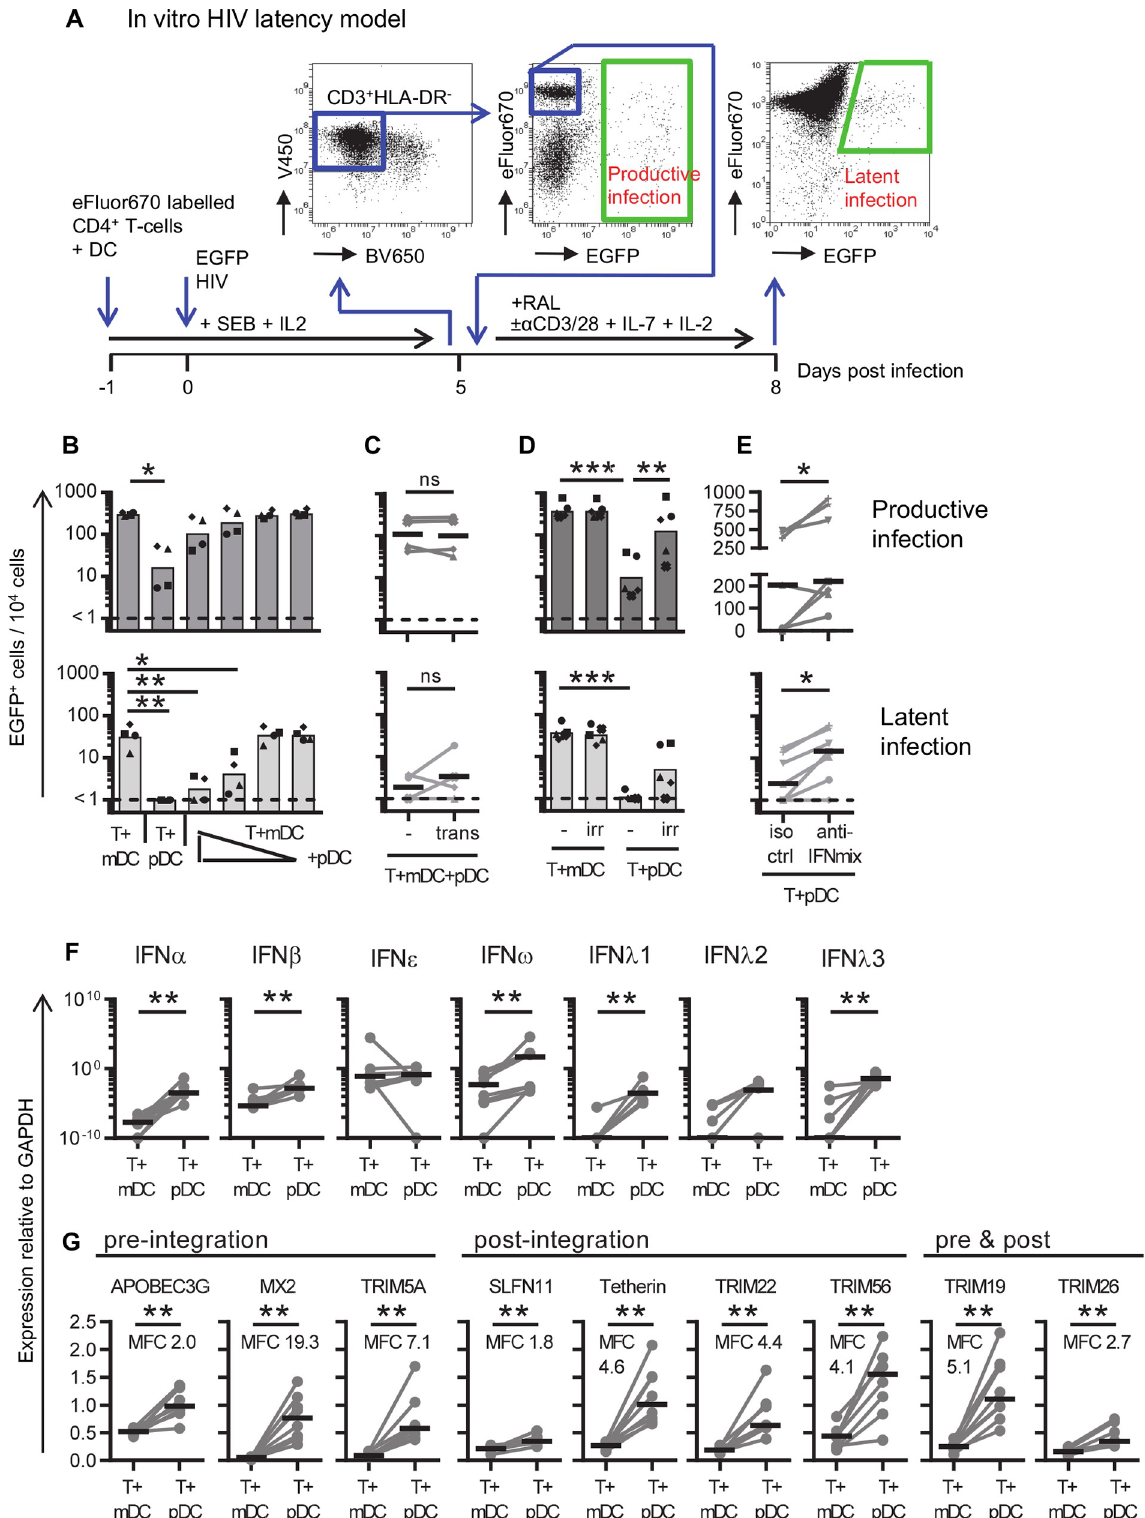
Fig 1. pDC-induced inhibition of HIV latency. A: Schematic of the in vitro DC-T cell HIV latency model. Resting CD4 + T cells were negatively selected using magnetic cell sorting, stained with the proliferation dye eFluor670 and cultured with and without syngeneic sorted